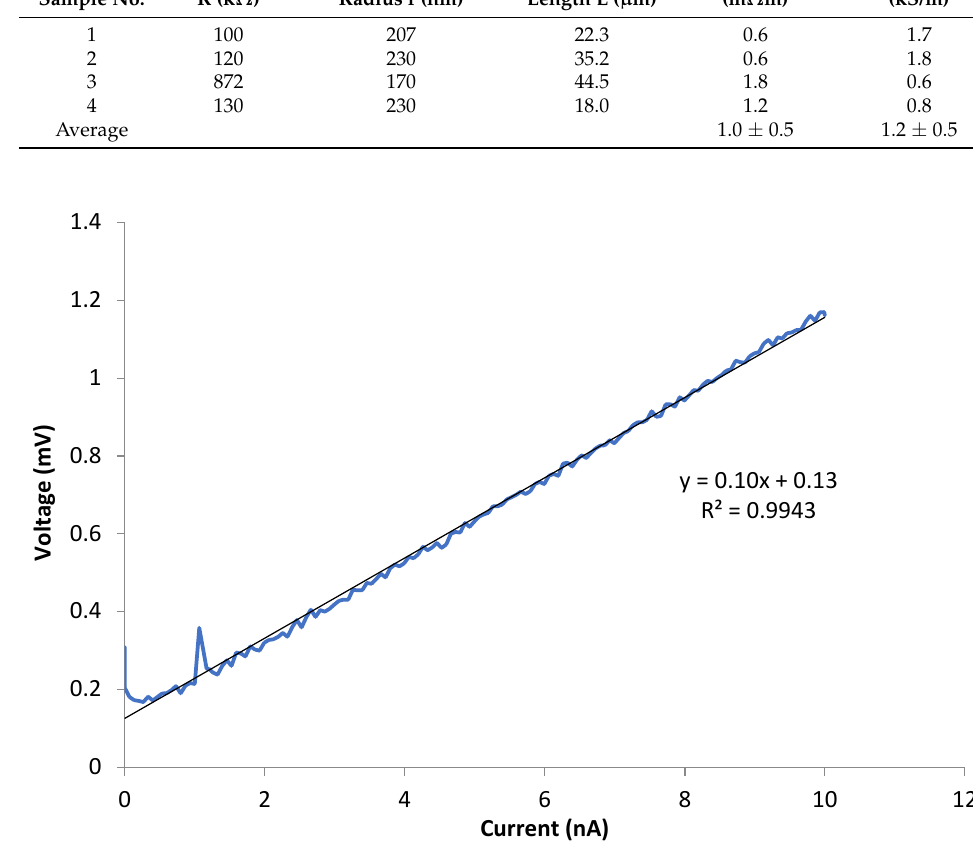
Figure 8. SEM image of a single TiON/C - CNF2 with four - probe contact on a Protochips electrical chip. Table 2. Table of resistivity, dimensions and specific resistivity of single TiON/C - CNF2s. Nanofiber Sample No.